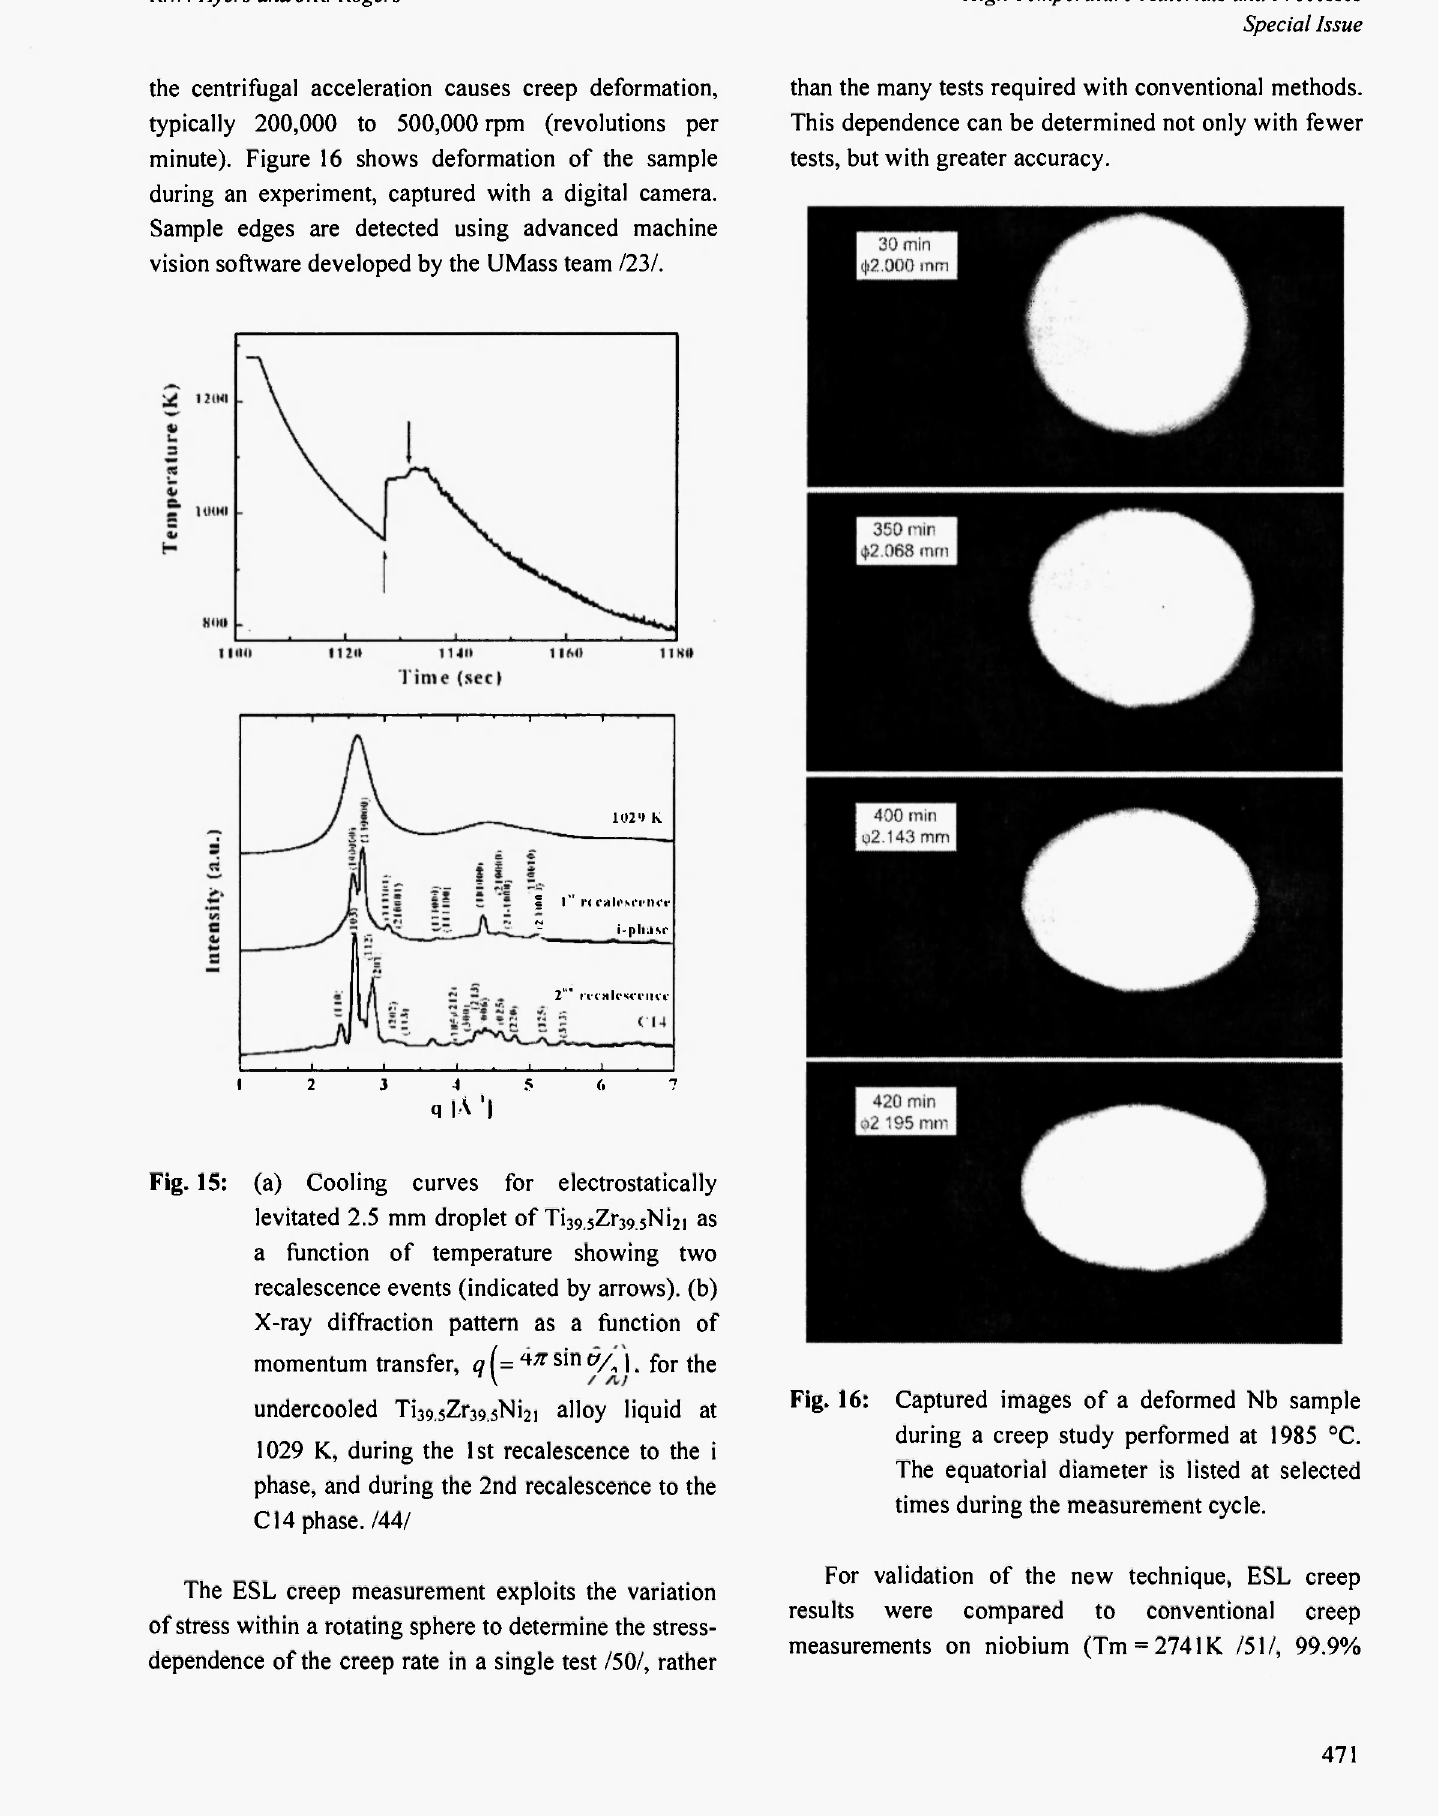
Fig. 15: (a) Cooling curves for electrostatically levitated 2.5 mm droplet of Ti 3 9 5Zr39 5 Ni2i as a function of temperature showing two recalescence events (indicated by arrows), (b) X-ray diffraction pattern as a function of momentum transfer, f/|= sin for the undercooled ^ ^ Z ^ l ^i alloy liquid at 1029 K, during the 1st recalescence to the i phase, and during the 2nd recalescence to the C14 phase./44/